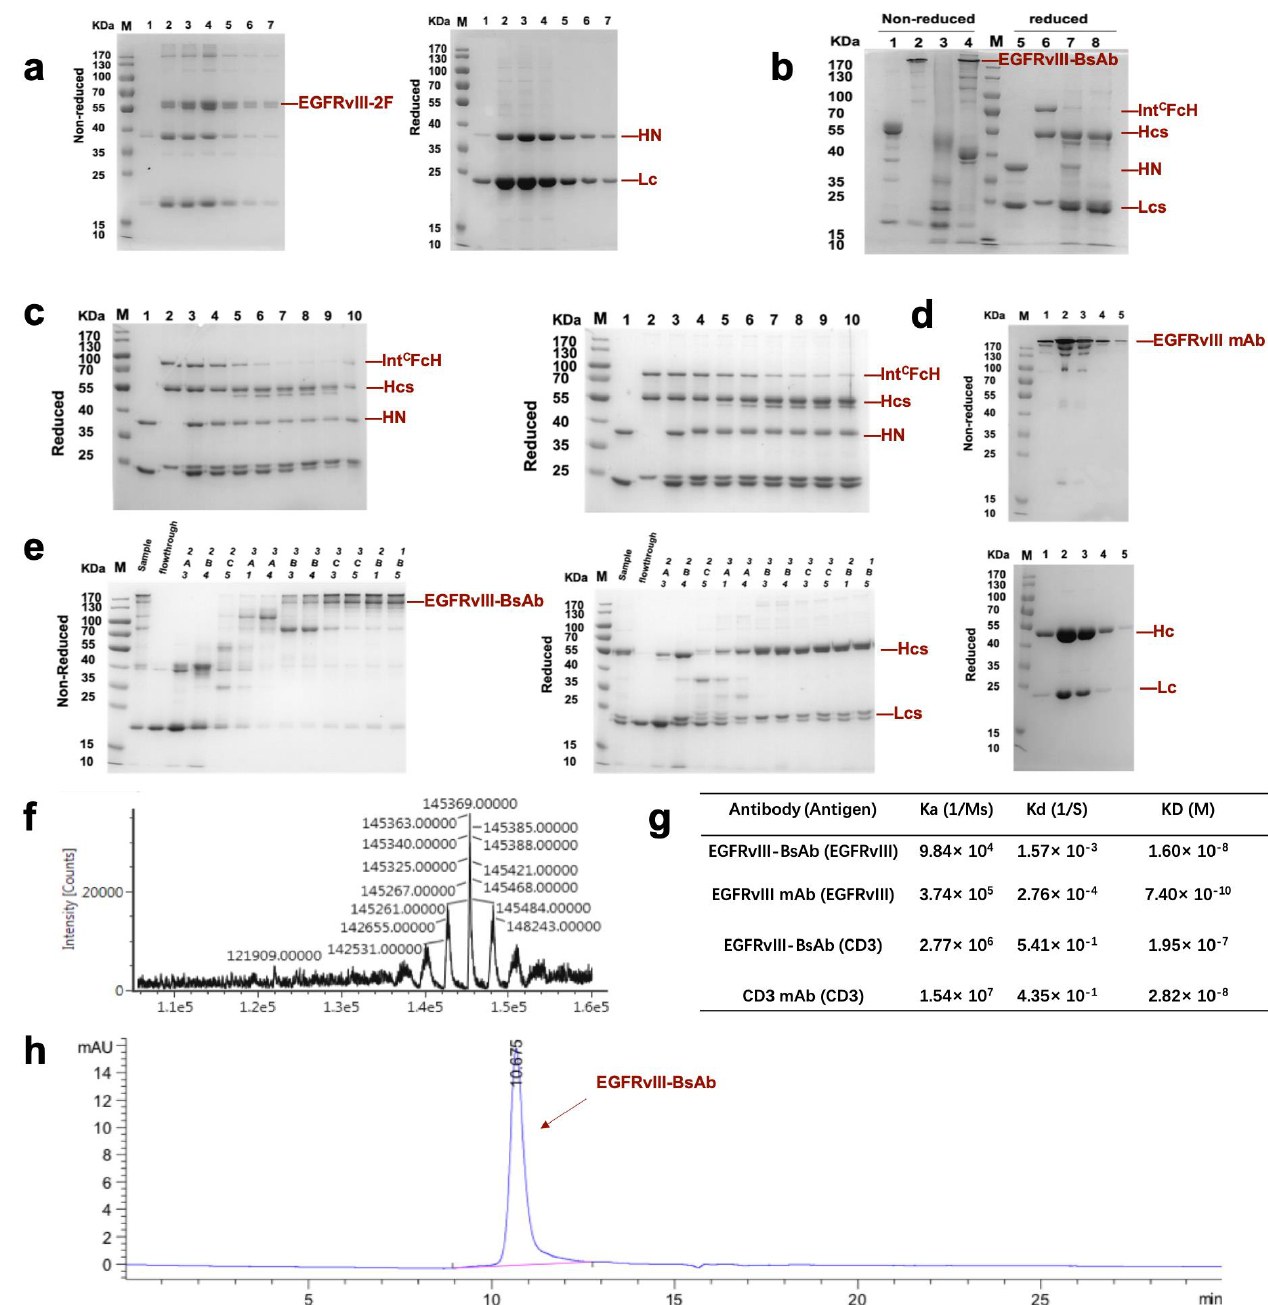
Figure 2. The generation and characterization of EGFRvIII-BsAb with the BAPTS method. ( a ) SDS-PAGE analysis of EGFRvIII-2F (fragment B) under nonreduced and reduced conditions. ( b ) SDS-PAGE analysis of BAPTS reaction. Bands 1,5 — EGFRvIII-2F (fragment B); bands 2,6 — CD3-3F (fragment A); bands 3,7 — BAPTS reaction catalyzed by reduction agent; bands 4,8 — complete bispecific antibody obtained by the BAPTS reaction, and followed by oxidization reagent reconstitution. ( c ) Reduced SDS-PAGE analysis of BAPTS reaction condition optimization. Bands 1 – 10 represent EGFRvIII-2F, CD3-3F, the mixture of 2F and 3F in the presence of 0 mM, 0.01 mM, 0.05 mM, 0.1 mM, 0.5 mM, 1 mM, 2 mM, and 5 mM reduction agent. ( d ) Nonreduced (upper) and reduced (lower) SDS-PAGE analysis of purification products of EGFRvIII mAb. ( e ) Nonreduced (left) and reduced (right) SDS-PAGE analysis of purification products of EGFRvIII-BsAb with an MMC ImpRes Multimodal Chromatography Column. ( f ) LC/MS analysis of deglycosylated nonreduced BsAb. ( g ) SPR assay of the dissociation constant of EGFRvIII-BsAb and its control mAbs against recombinant target antigens. ( h ) SEC-HPLC analysis of EGFRvIII-BsAb.